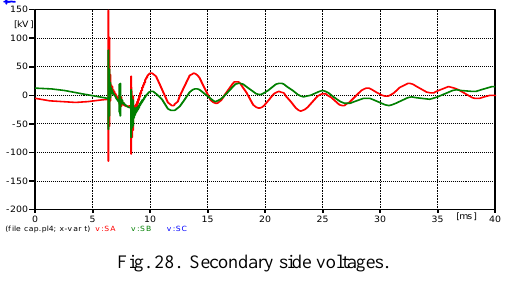
Fig. 28. Secondary side voltages.